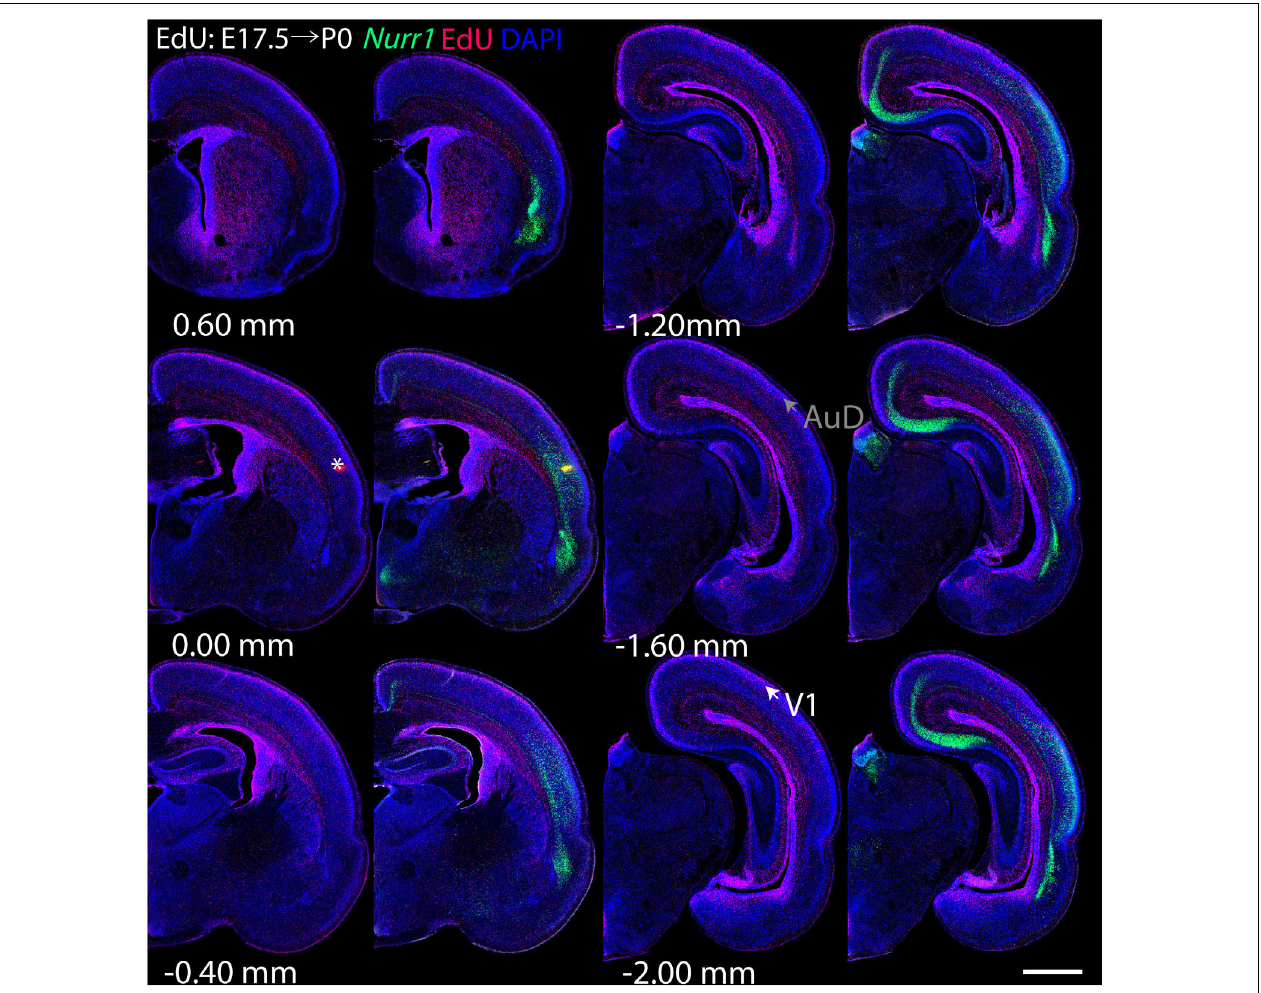
FIGURE 9 | Overview of EdU labeling on E17.5 with Nurr1 FISH on P0. White arrows indicate the EdU labeled regions. Gray arrows indicate the regions with reduced EdU labeling. AuD secondary auditory cortex, V1, primary visual cortex dorsal area. “ ∗ ” indicates staining artifacts. Numbers below sections indicate the bregma coordinate. N = 3 rats. Scale bar = 1